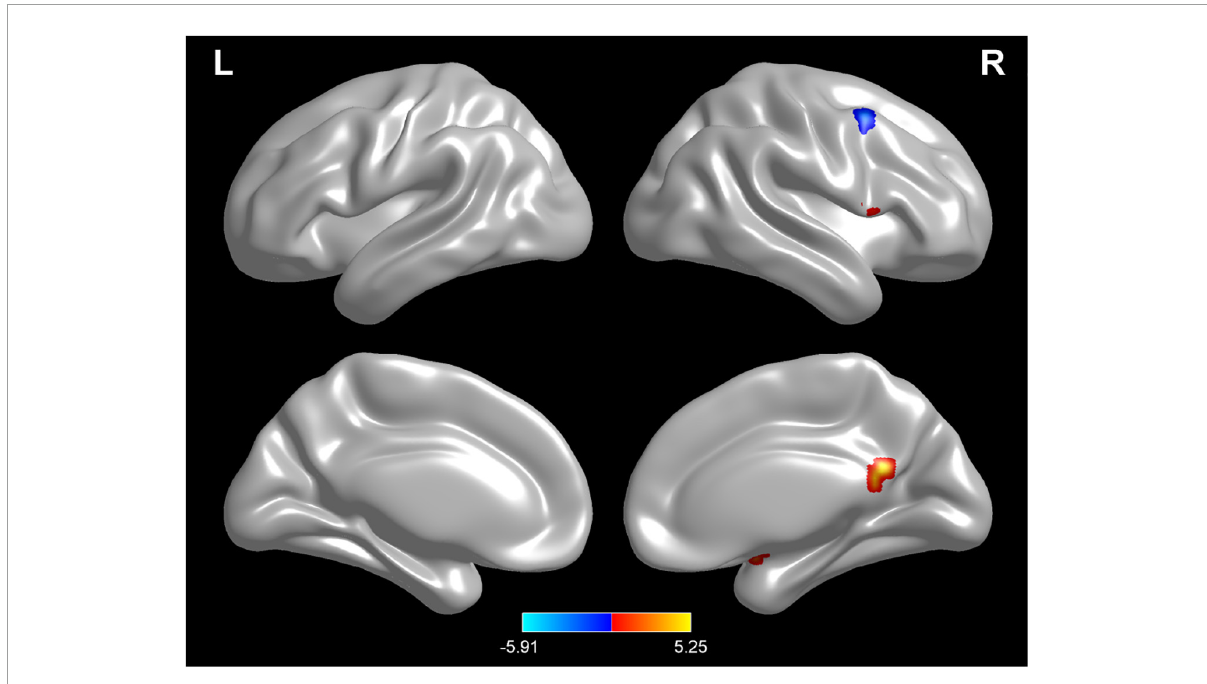
FIGURE7 Regional changes on the voxel-based three-dimensional displayed brain regional homogeneity (ReHo) among participants when compared with test 3 in rehydration state and test 2 in dehydration state. Warm colors mean that the ReHo value among participants in the rehydration test was higher than that in the dehydration test; cold colors mean that the ReHo value among participants in the rehydration test was lower than that in the dehydration test; p < 0.05 after false-discovery rate correction, voxel threshold of cluster >